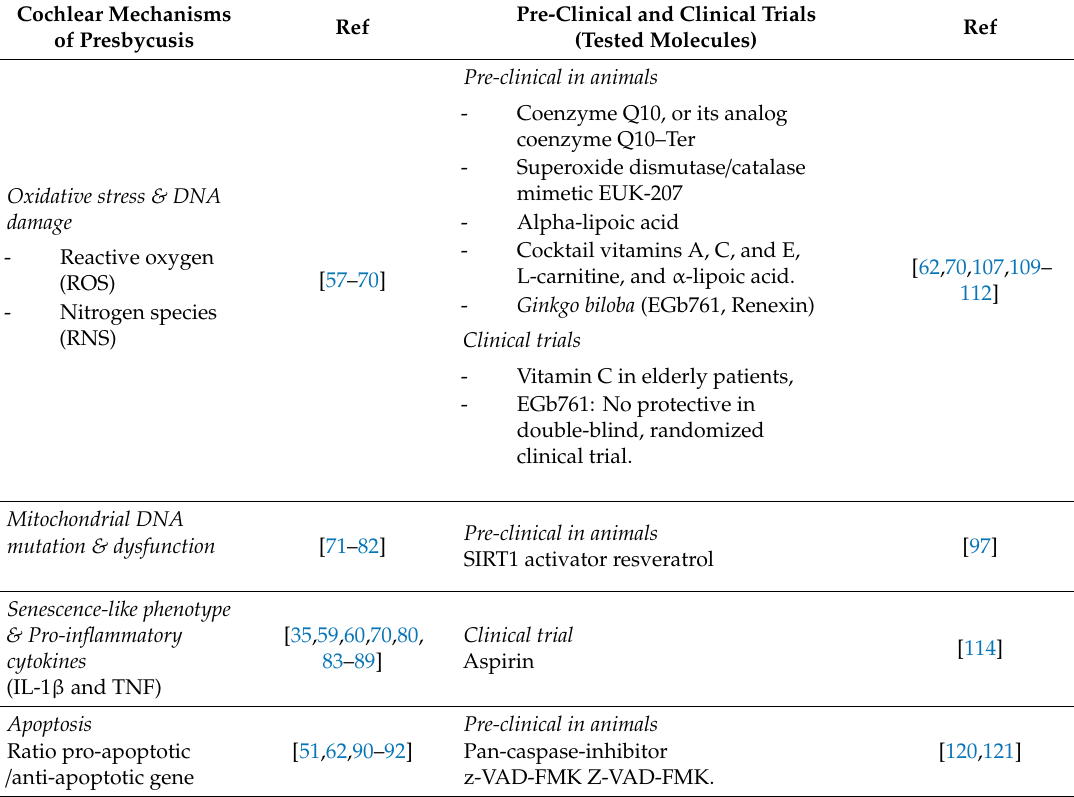
Table 1. Cochlear mechanisms and therapies summarizing the pre-clinical and the clinical trials related to presbycusis with the corresponding